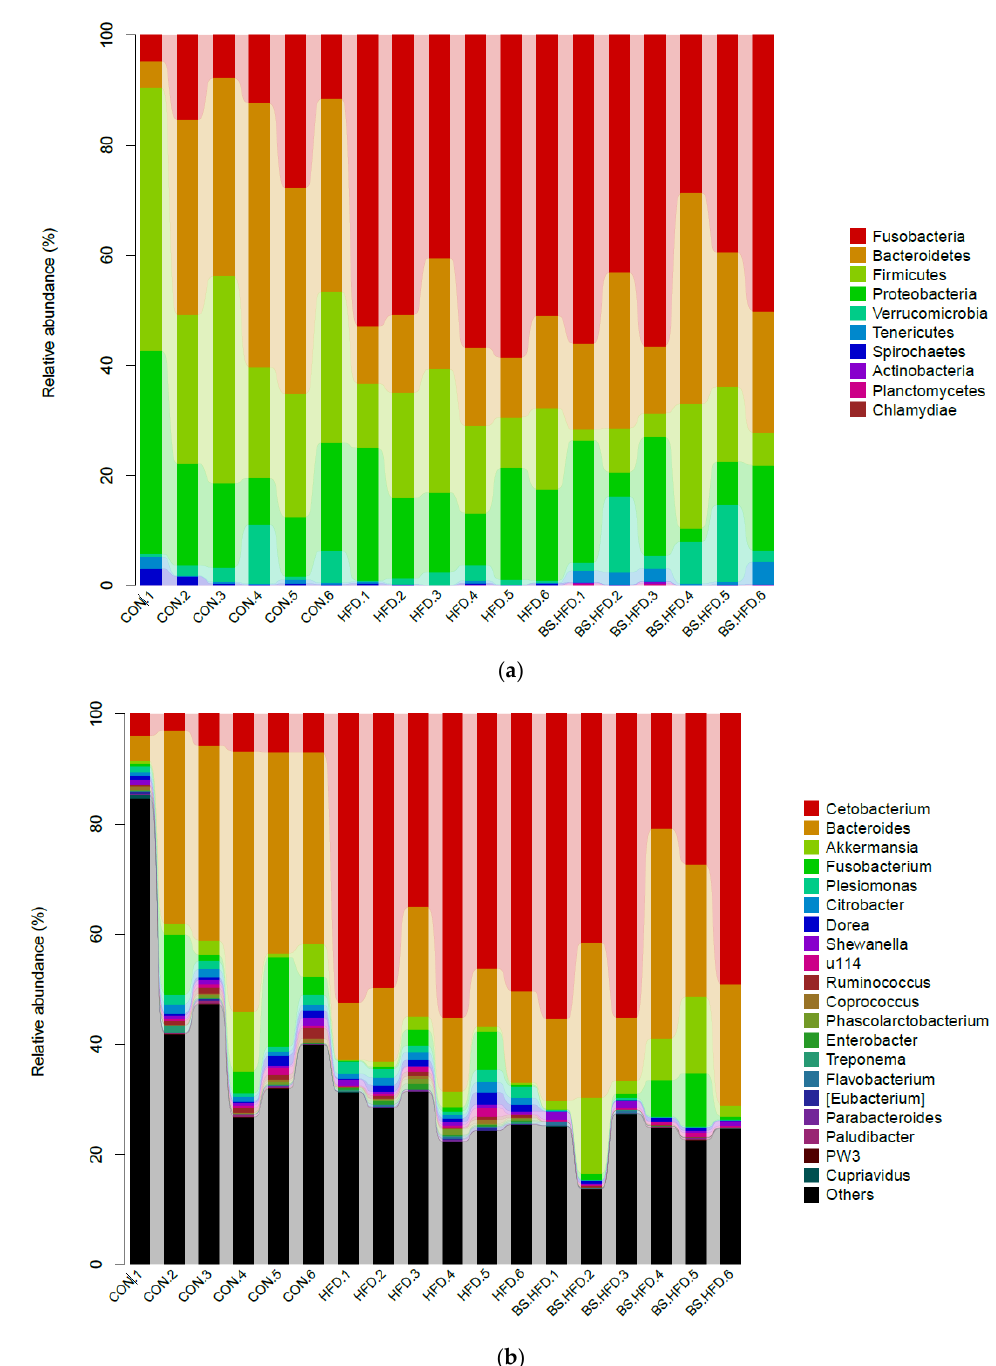
Figure 3. Composition of the intestinal microbiota of C. idella at phylum ( a ) and genus levels ( b ). At the genus level, the dominant genera in the CON group included Bacteroides (32.33%), an unclassified genus of Erysipelotrichaceae (23.65%), an unclassified genus of Enterobacteriaceae (13.04%), Fusobacterium (6.02%), Cetobacterium (5.54%), Akkermansia (3.72%), an unclassified genus of Lachnospiraceae (2.10%), Plesiomonas (1.24%), an un- classified genus of Aeromonadaceae (1.21%), an unclassified genus of Ruminococcaceae (1.15%), Citrobacter (1.11%) and an unclassified genus of Fusobacteriaceae (1.11%). In the HFD group, the dominant intestinal genera were Cetobacterium (48.14%), Bacteroides (14.04%), an unclassified genus of Enterobacteriaceae (11.34%), an unclassified genus of Erysipelotrichaceae (8.78%), an unclassified genus of Ruminococcaceae (3.04%),